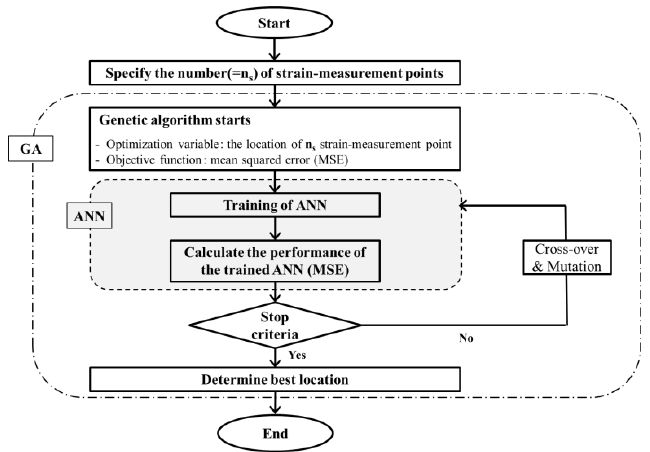
Figure 3. Flowchart for optimizing strain-measurement points using the GA in conjunction with the ANN. Table 1. General information for the artificial neural network (ANN) model.